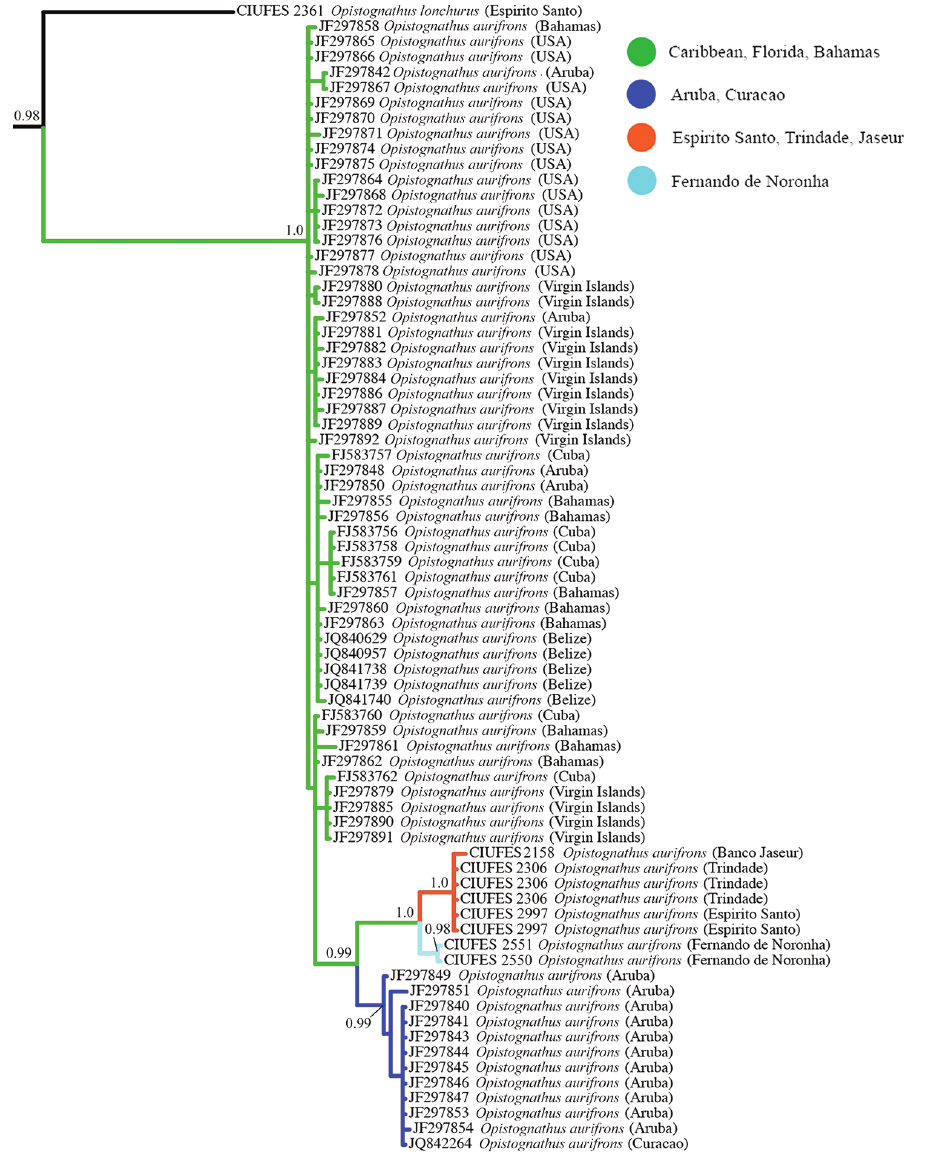
Figure 24. Bayesian inference phylogeny of the Opistognathus aurifrons complex. Support values are Bayesian posterior probabilities. Nodes without support values shown have <0.90 support. Scale bar units are expected number of substitutions per